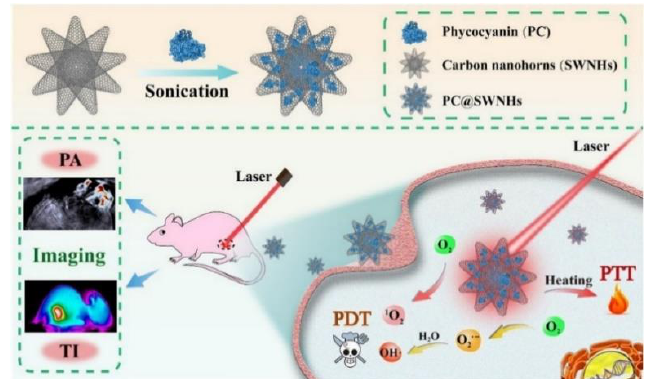
Figure 5. Schematic representation of the route for synthesis of Phycocyanin @ Single Walled Carbon Nanohorns and its use for Near Infrared light-mediated Photothermal / Photodynamic therapy of tumors. Reproduced with permission from [103]. Elsevier (2017).